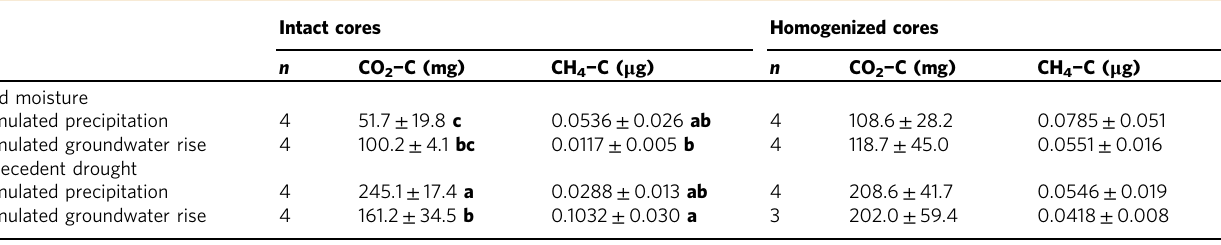
Table 3 Cumulative carbonaceous greenhouse gas emissions from incubated cores measured during rewetting and for 20 h post rewetting